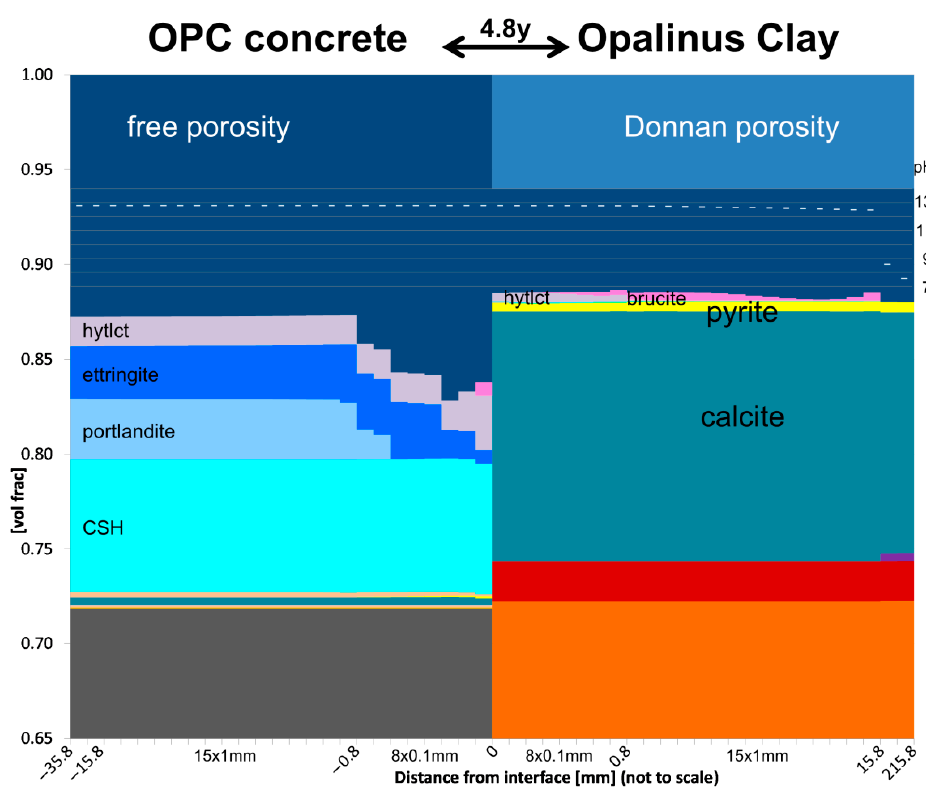
Figure 5. Predicted volume evolution of the reactive phases after 4.8 y of interaction of ESDRED (top), and OPC (bottom, modified from [14]) with OPA. The phase legend and explanation of horizontal axis is shown in Figure 1 and captions, the pH of the free porewater is indicated in the dark blue free porosity area.